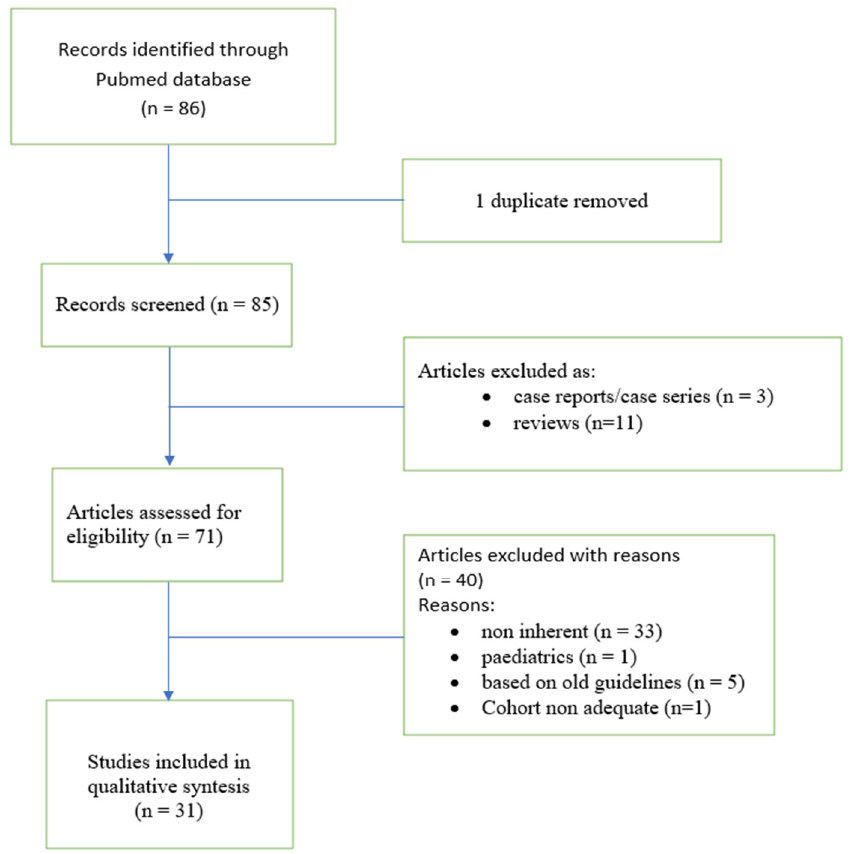
Figure 1. Flowchart of the study.